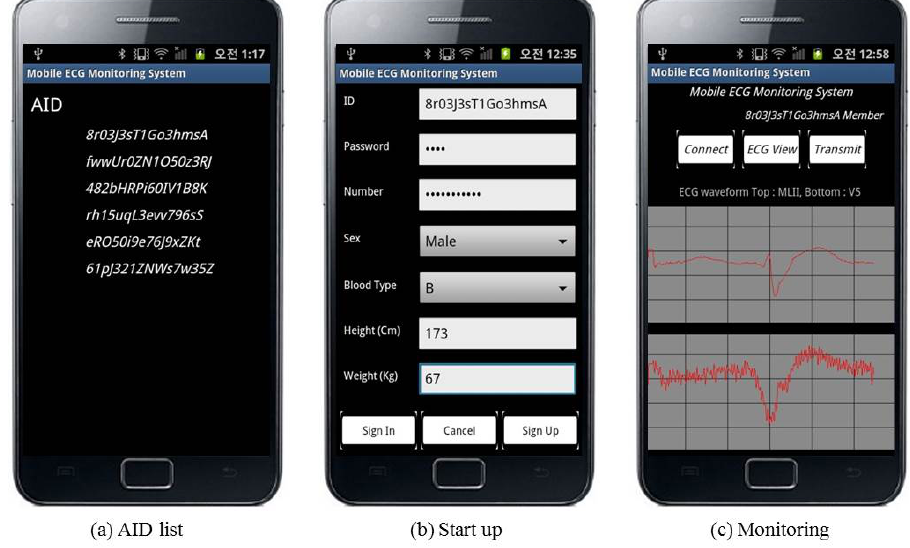
Figure 6. Results of mobile device implementation.